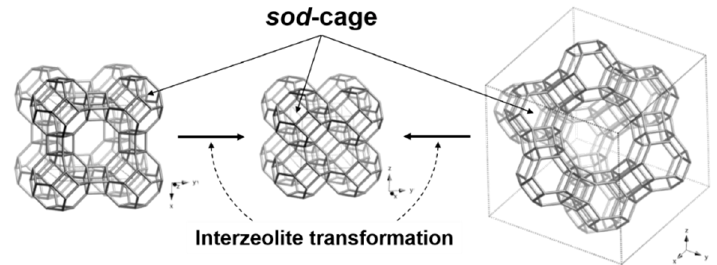
Figure 1. Schematic illustration of the interzeolite transformation of LTA (left) and FAU (right) to sodalite (SOD) (middle).